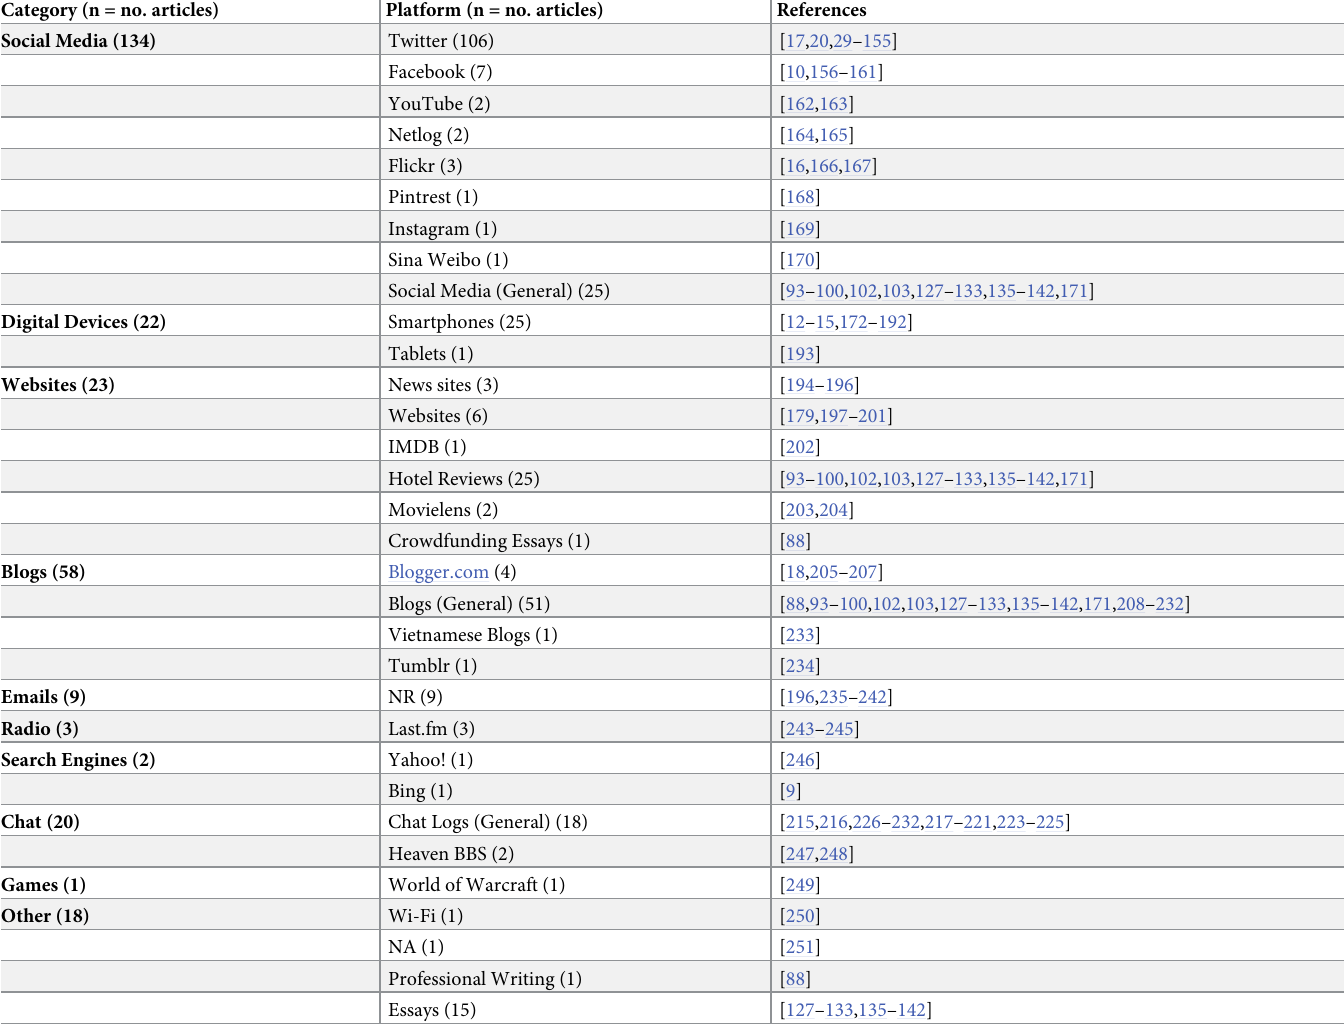
Table 1. Number of articles predicting gender, with associated platforms and references. Category (n = no.